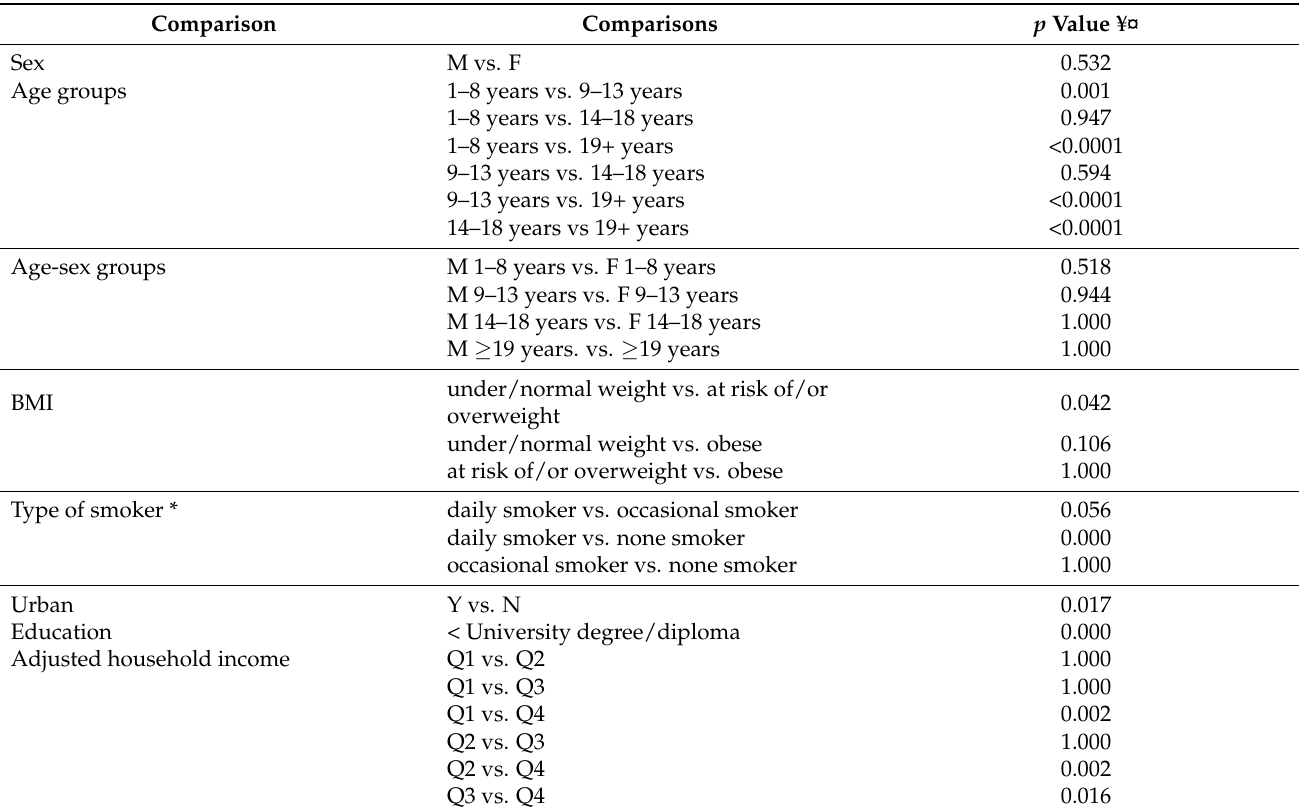
Table A1. t -tests for differences between mean intake of %E from free sugars in Canadian population ≥ 1 years.